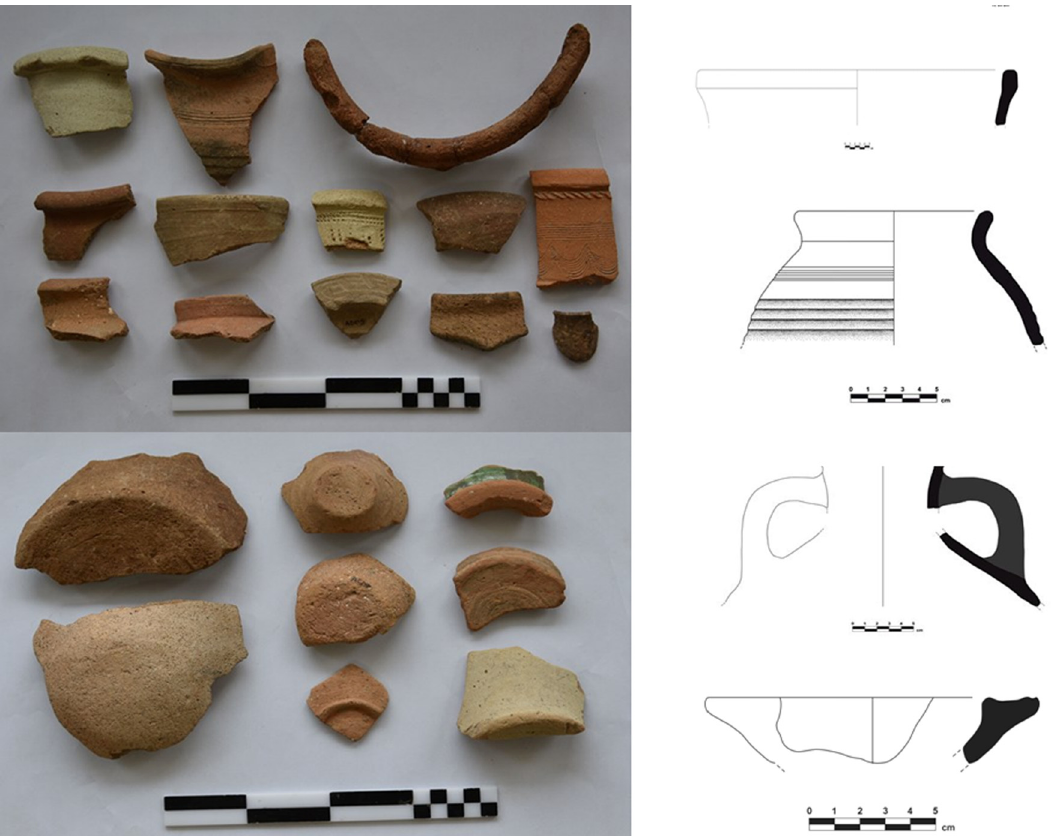
Figure 10: Sample sherds ( left ) and selected drawings ( right ) ( Ambarçay Salvage Excavation Archive )